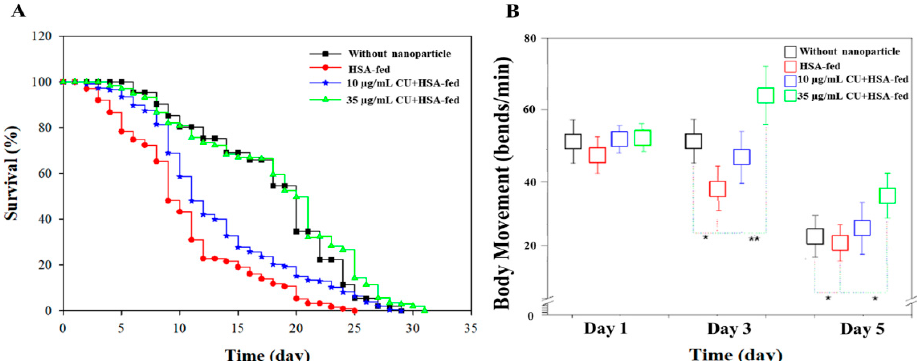
Figure 2. Biological safety of CUHNP in C. elegans . Lifespan ( A ) and body movement ( B ) of C. elegans that were cultured without nanoparticles, with HSA, and with 10 µg/mL and 35 µg/mL of CU-loaded HSA nanoparticles (CUHNP or CU + HSA), respectively. The data present the mean ± S.D. from three independent experiments ( p < 0.01).